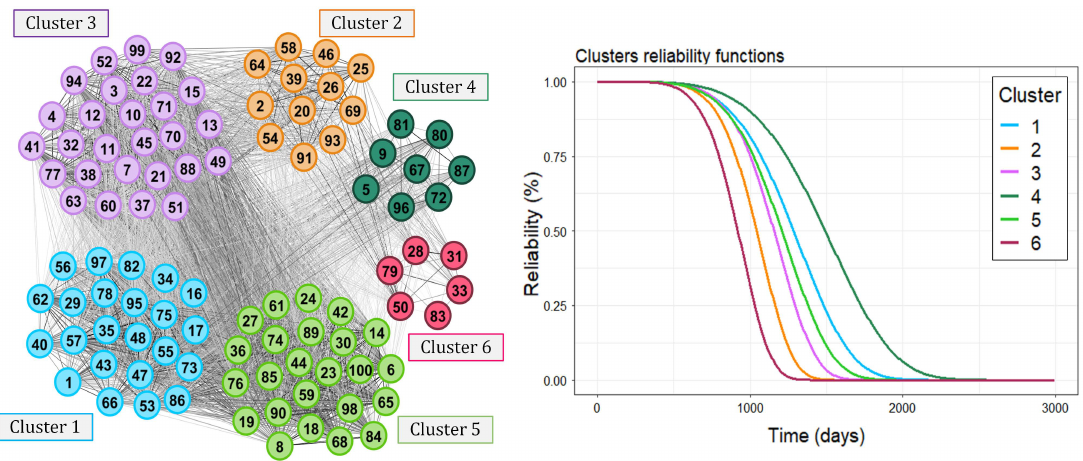
Figure 4. Clusterization example. Minor failure mode of the